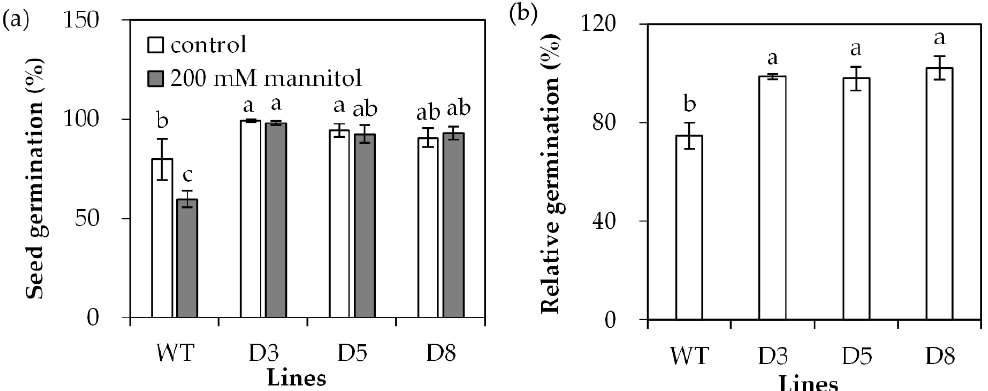
Figure 5. Seed germination in transgenic plants in comparison with the wild type (WT) in response to osmotic stress. Sterilized seeds were placed on 1/2 MS medium containing 200 mM mannitol or without it as control for 4 days for determination of germination rate ( a ), and the data were used to calculate relative germination rate ( b ). Means of three replicates and standard errors are presented; the same letter above the column indicates no significant difference at p <